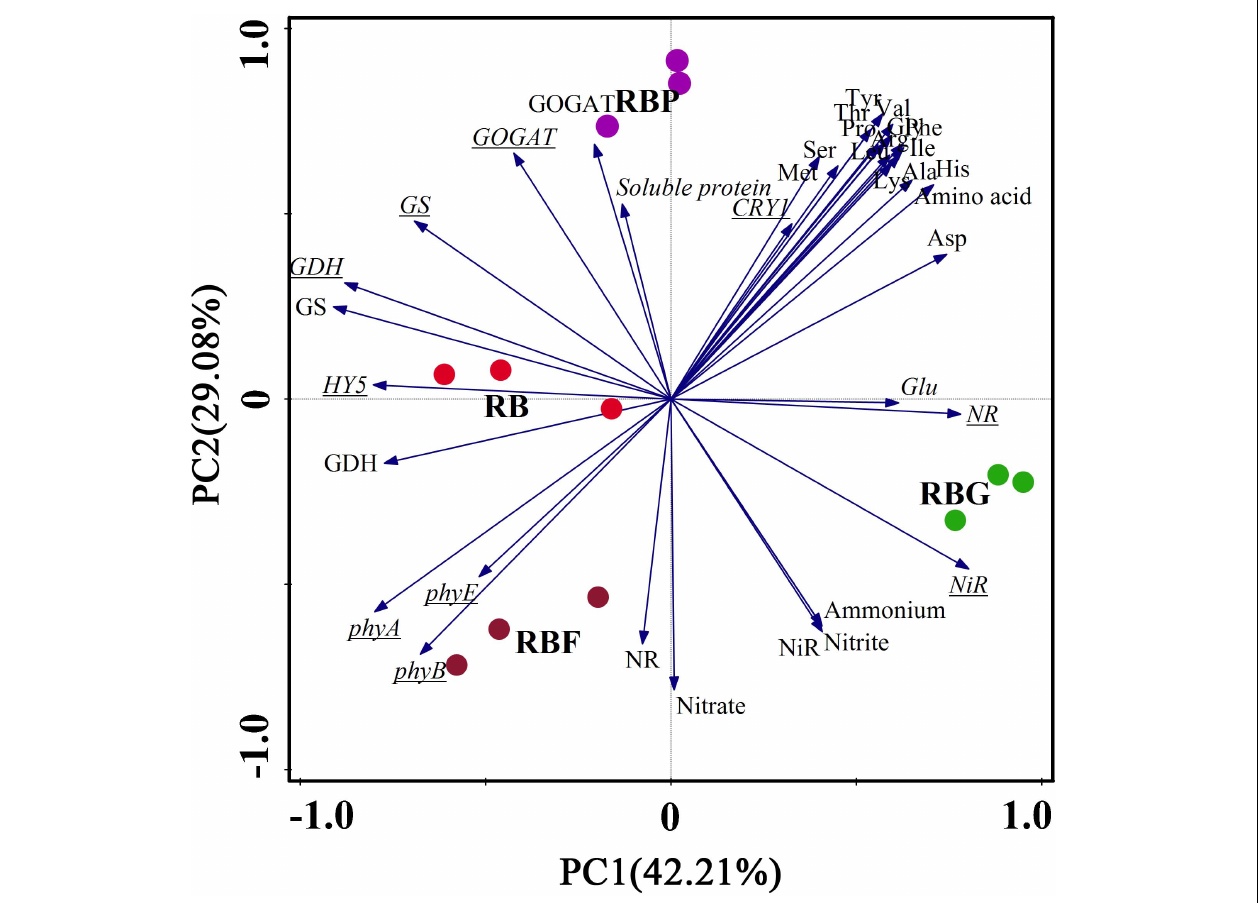
FIGURE 7 | Principal component analysis (PCA) showing differences and correlations in nitrogen assimilation in lettuce leaves under different illumination spectrum. Scatter plot with different color indicated four light treatments ( n = 3 replications). Underlined letters indicate genes expression. RB, 75% red + 25% blue LED;